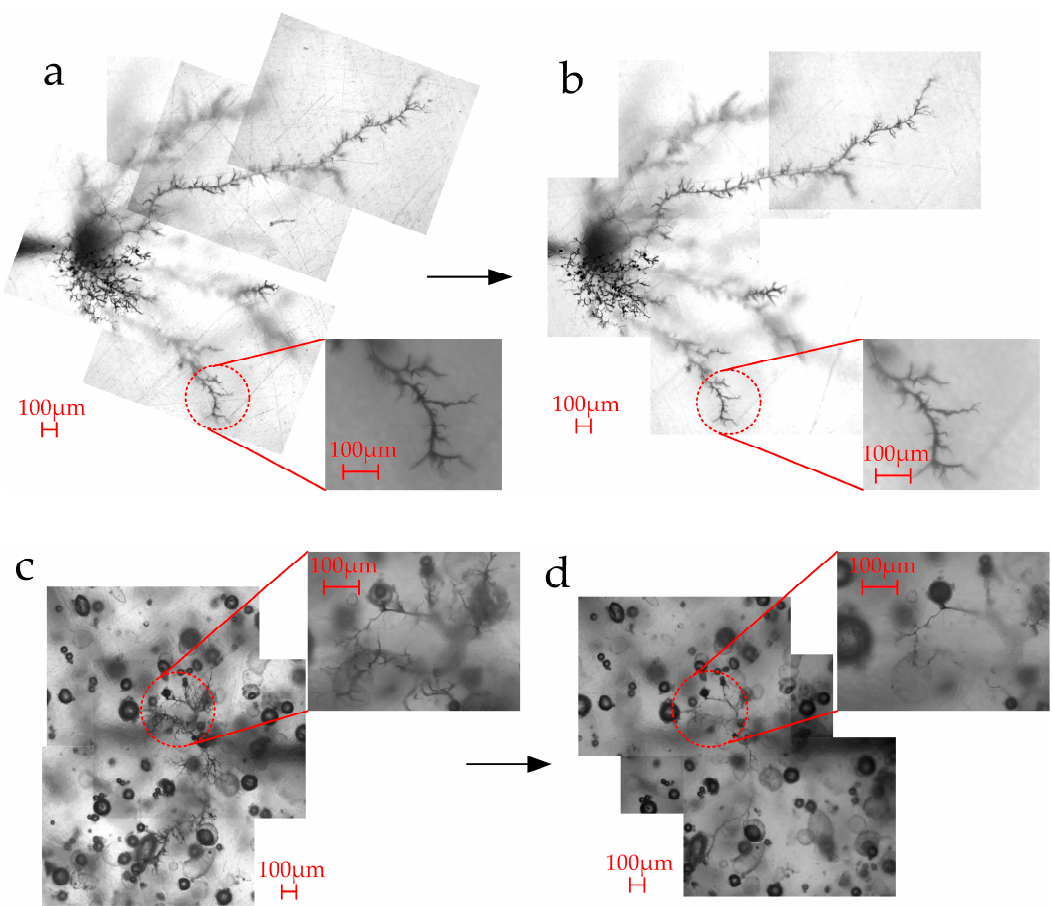
Figure 4. Morphology of electrical tree. ( a ) Unheated pure LDPE. ( b ) Heated pure LDPE. ( c ) Unheated composite. ( d ) Heated composite.